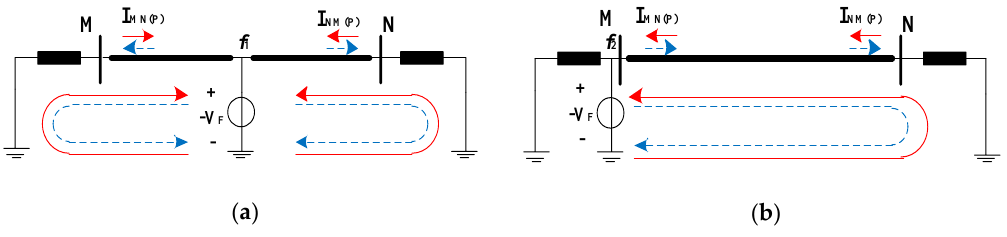
Figure 3. ( a ) Schematic of fault superimposed circuit and traveling wave propagation when internal fault f 1 occurs; ( b ) Schematic of fault superimposed circuit and traveling wave propagation when external fault f 2